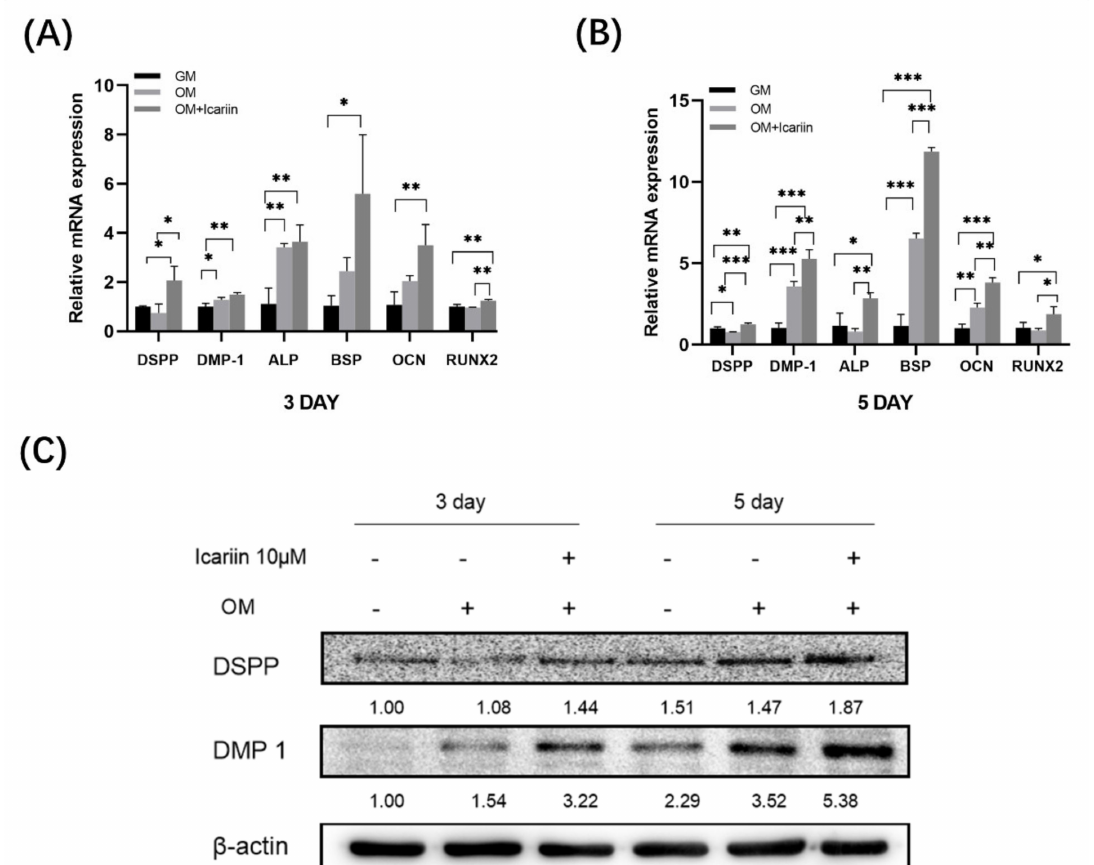
Figure 3. Effect of icariin on odontogenic differentiation of HDPCs. ( A , B ) Effect of icariin treatment on the expression of odontogenic differentiation markers at mRNA level. HDPCs were treated with 10 µ M of icariin for 3 or 5 days. Expression levels of DSPP , DMP 1 , ALP , BSP , OCN , and RUNX 2 mRNAs were measured by quantitative real-time PCR. Gene expression was normalized against GAPDH (* p < 0.05, ** p < 0.01, *** p < 0.001). ( C ) DSPP and DMP 1 protein levels were upregulated after treatment with icariin at 3 or 5 days compared with both GM and OM. Bars show means ± standard deviation ( DMP 1 : dentin matrix protein 1, DSPP : dentin sialophosphoprotein, RUNX2 : runt- related transcription factor 2, OCN : osteocalcin, BSP : bone sialoprotein and GAPDH : Glyceraldehyde- phosphate